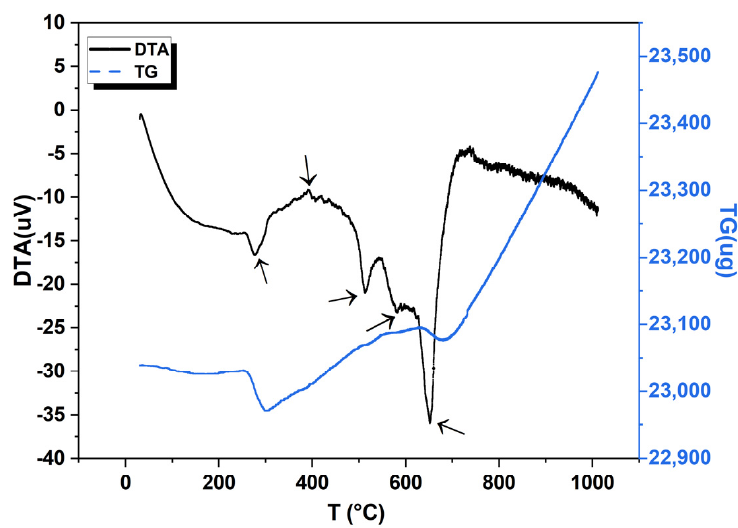
Figure 3. TG − DTA curve of the mixed powder